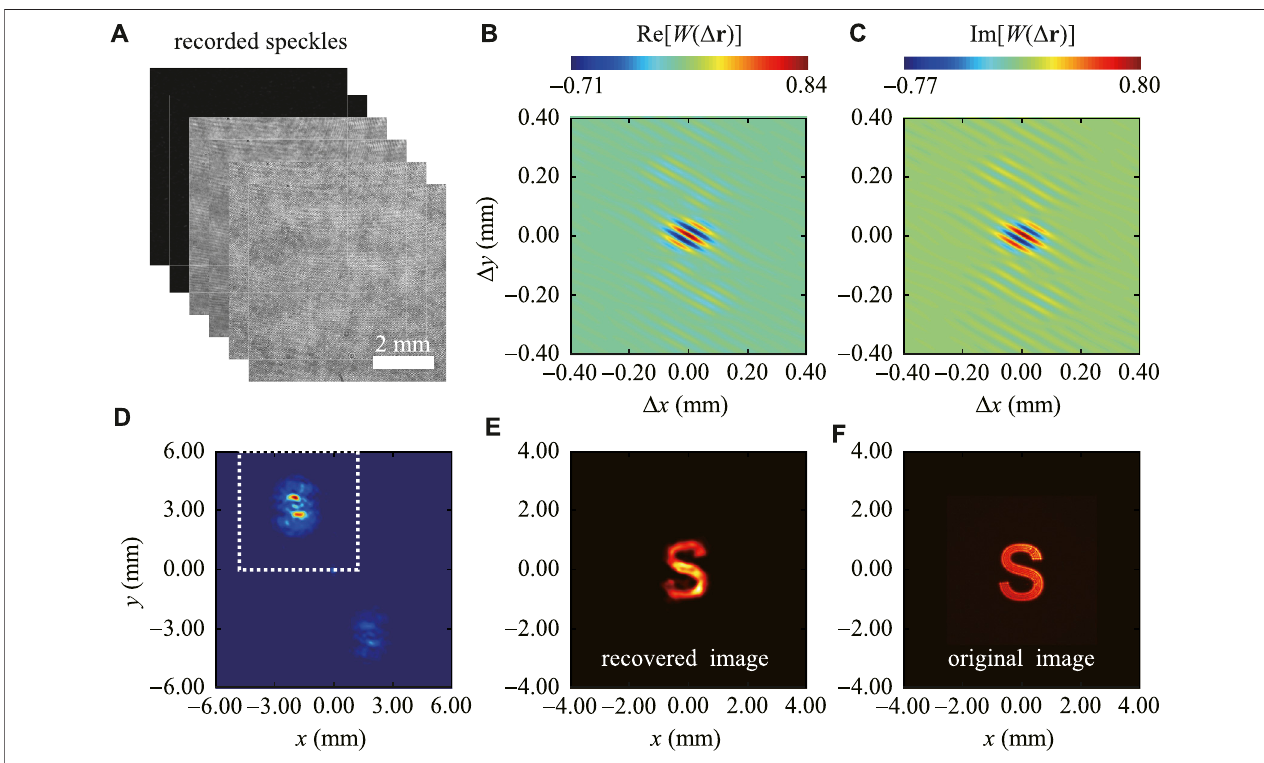
FIGURE3| Experimental results ofopticalimagingthroughaRGGDwithcomplexspatialcoherencemeasurement.Theopticalimageisplaced57.5 cminfrontof the random scatterer. (A) The recorded speckles I nx ( r ), I ny ( r ), I circ x ( r ) , I circ y ( r ) , I add nx ( r ) , and I add ny ( r ) . (B) and (C) The recovered real and imaginary parts of the spatial coherence function from the speckles shown in (a). (D) The recovery intensity on the front surface of the RGGD. (E) The recovery image information with the iterative phase retrieval algorithm. (F) The original image displayed in the